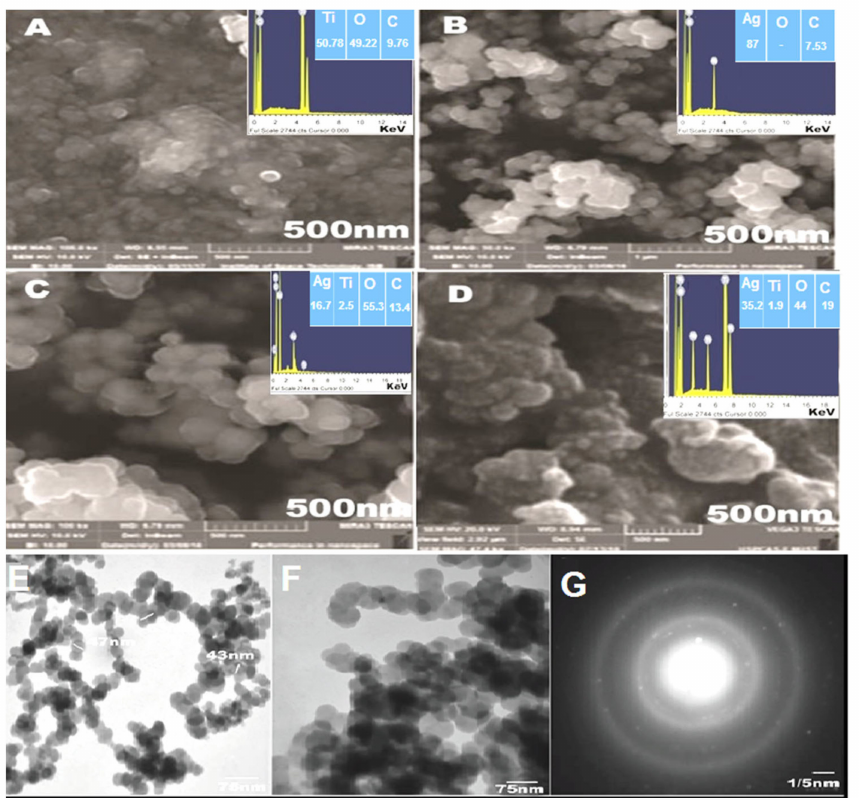
Figure 2. FESEM images of ( A ) TiO 2 NPs, ( B ) AgNPs, ( C ) TiO 2 /Ag nanocomposite, ( D ) CIP- TiO 2 /Ag/CS nanohybrid TEM analysis, ( E ) TiO 2 /Ag composites, ( F ) CIP-TiO 2 /Ag/CS nanohybrids, and ( G ) selected area electron diffraction